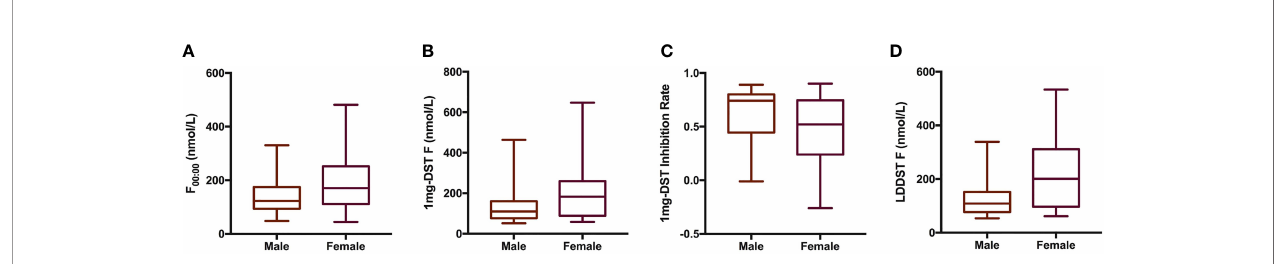
FIGURE 1 | Cortisol-related indices of male and female patients with MACS. Box plots presented cortisol related indices including F 00:00 (A) , 1mg-DST F (B) , 1mg- DST Inhibition Rate (C) and LDDST (D) of male (n = 33) and female (n = 65) patients with MACS. The blank bar within the box represents the median. The box refers to the upper ( 75 th percentile) and lower ( 25 th percentile) hinges. Maximum and minimum values are represented by whiskers. F 00:00 , cortisol level at 00:00; 1mg DST, 1-mg overnight dexamethasone test; LDDST, low-dose dexamethasone test.